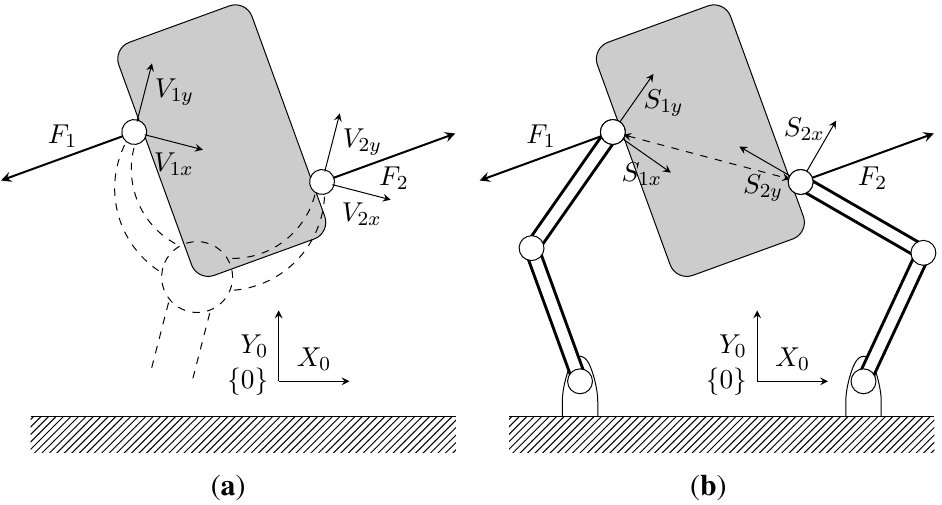
Figure 2. Two-dimensional representation of a physical gripper with force sensors along directions S and S and a virtual gripper with virtual force sensors along the directions of ix iy V and V . ( a ) Virtual gripper; ( b ) physical gripper. ix iy